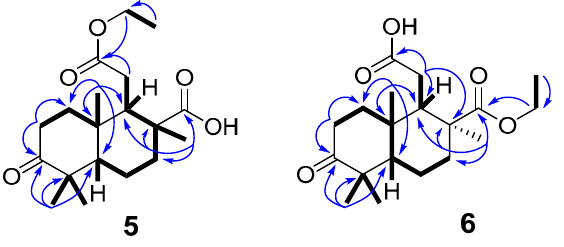
) and HMBC ( Figure 2. Selected COSY ( ), HMBC ( ) and ROESY ( ) correlations of 1 and 2 . ) correlations of 5 and 6 Figure 2. Selected COSY ( ), HMBC ( ) and ROESY ( ) correlations of 1 and 2 . Figure 7. Selected COSY ( ) and HMBC ( ) correlations of 5 and 6 . Figure 7. Selected COSY (